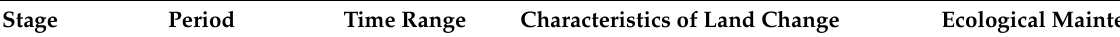
Table 9. Summary of land development change and ecological